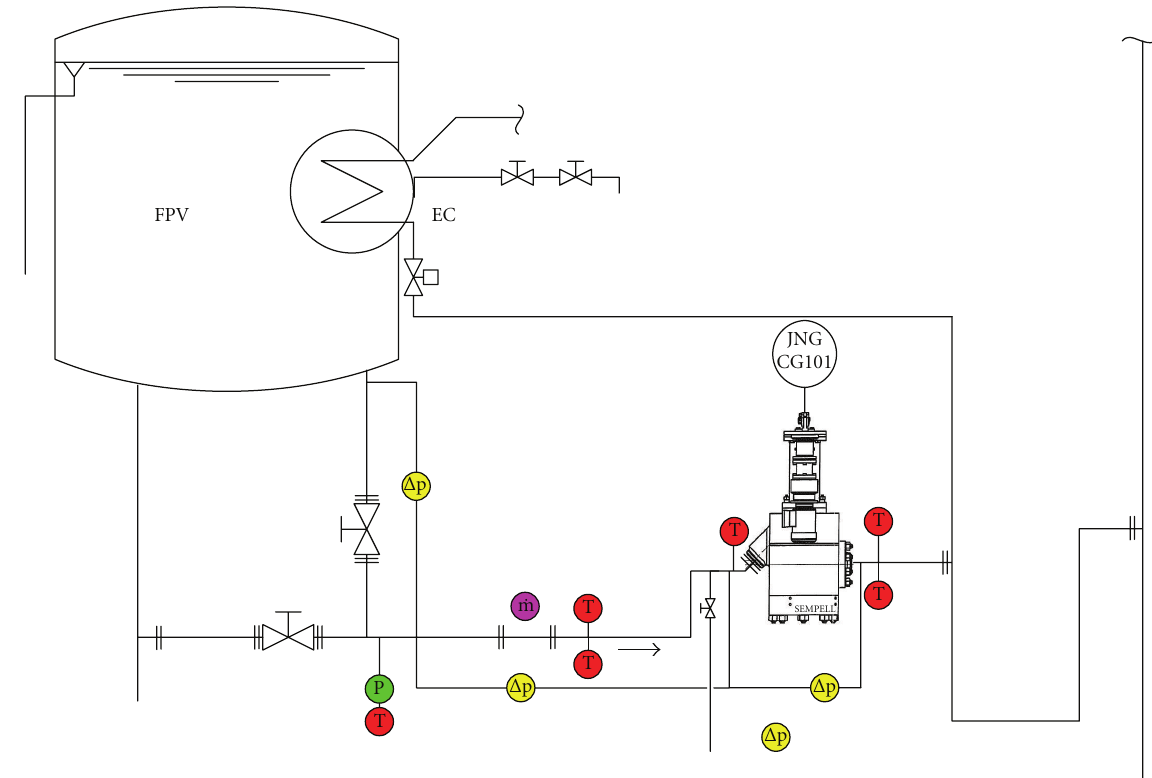
Figure 14: Instrumentation of the Passive Core Flooding